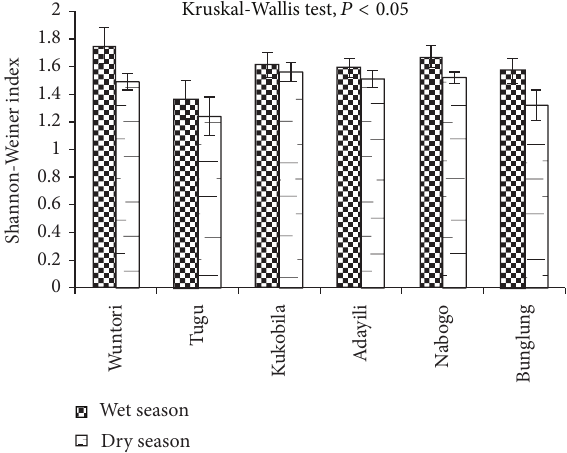
Figure 3: Variations in mean diversity in the wet and dry season.